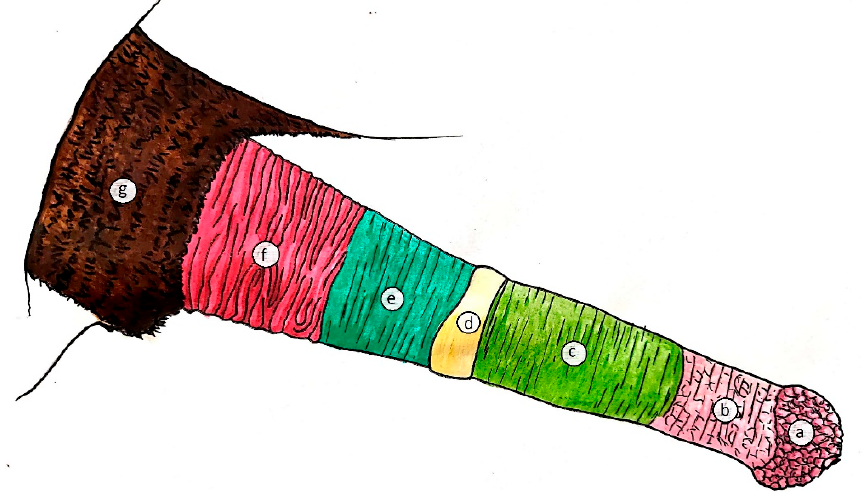
Figure 2. Schematic drawing of the external aspect of the equine penis protruded from the prepuce. ( a ) glans penis; ( b ) free part of the penis; ( c ) inner lamina of the internal fold; ( d ) preputial ring; ( e ) outer lamina of the internal fold; ( f ) inner lamina of the external fold; ( g ) outer lamina of the external